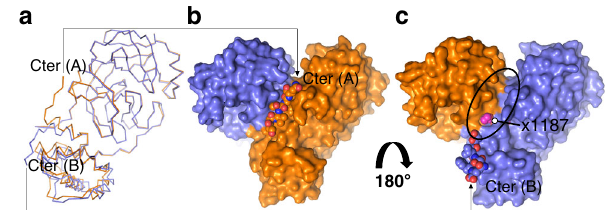
Fig. 6 Captured alternate SARS-CoV-2 M pro C-terminal conformations can inform drug discovery. a Superposition of SARS-CoV-2 M pro acyl- enzyme intermediate protomers determined here with chain A and chain B in orange and blue, respectively. The alternate C-terminal orientations — labeled Cter (A) and (B) — observed reveal a druggable pocket at the dimerization interface. Arrows connect to corresponding C-terminal orientation in ( b ) and ( c ). b The C-terminus of chain A (orange VdW representations) is packed at and stabilizes the dimerization interface (blue and oranges surfaces), an interaction typical of the mature dimer. c In the acyl-enzyme and product complexes, chain B redirects its C-terminus ~180° (blue VdW representations) as also shown in ( a ), allowing capture within the active site cleft of a neighboring dimer in the crystal, with the extended peptide binding groove at the dimerization site now exposed (delineated by black ellipse). A recent structure-based fragment screen found several small molecules bound within this region including compound x1187 (magenta spheres; PDB